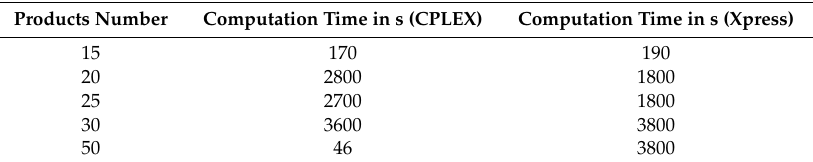
Table 7. Results of